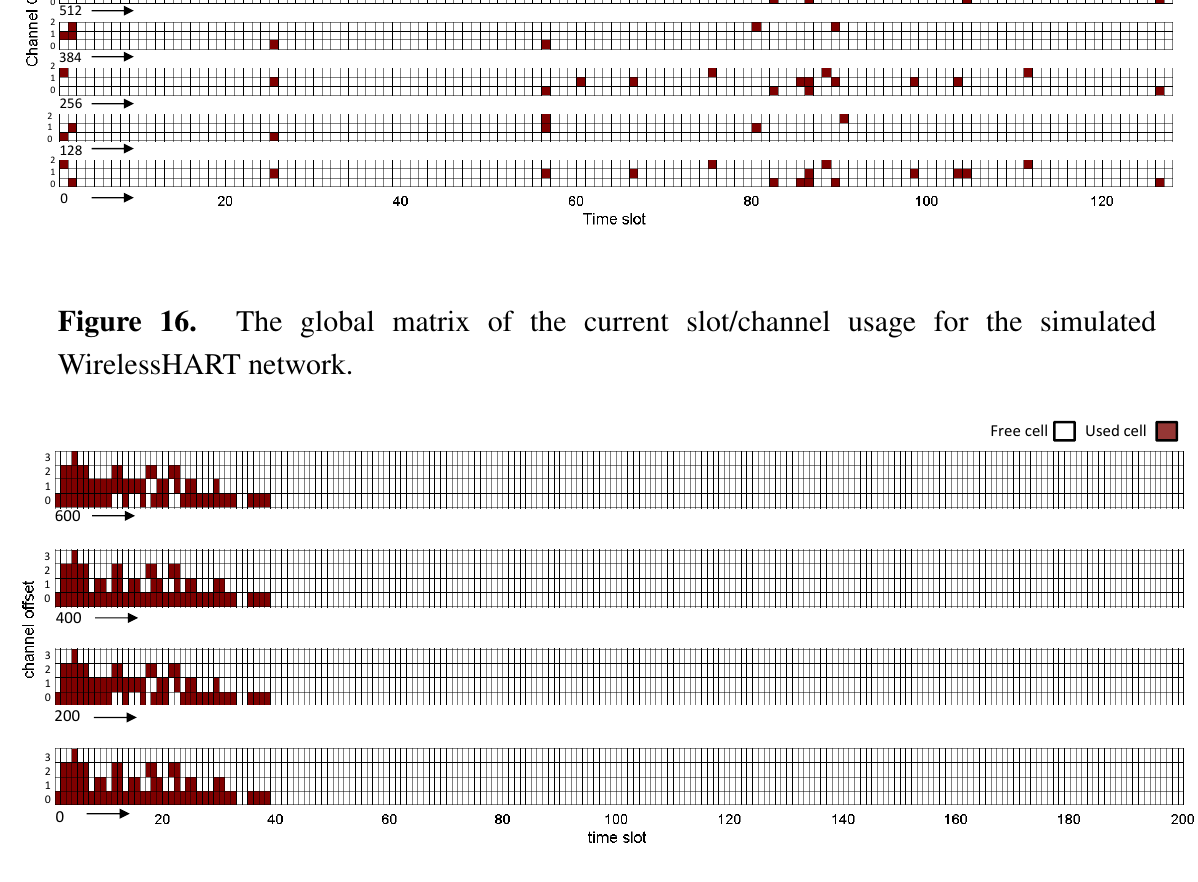
Figure 15. The global matrix of the current slot/channel usage for the real WirelessHART network (the combination of superframes with sizes of 128, 256 and 1,024 time slots). 128256384512640768896